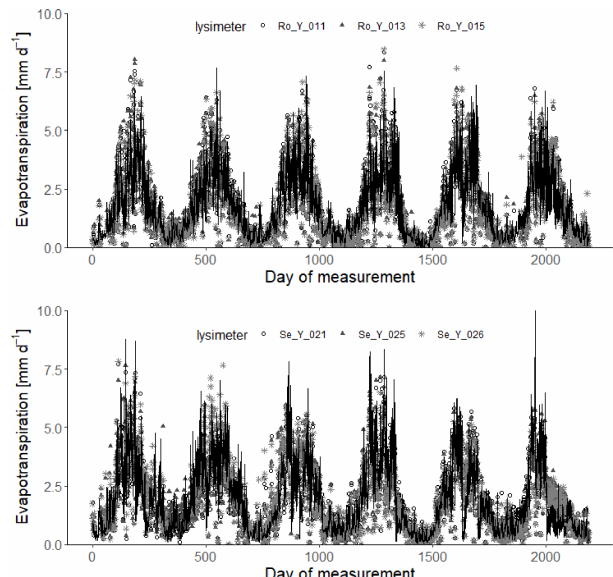
Figure 5. Measured daily evapotranspiration rates (symbols; 2013– 2018) compared with simulations for the 30 acceptable parameteri- zations at each site (black lines). Day 1 is 1 January 2013.